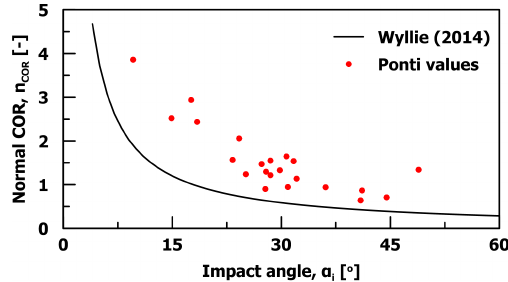
Figure 12. Normal COR versus impact